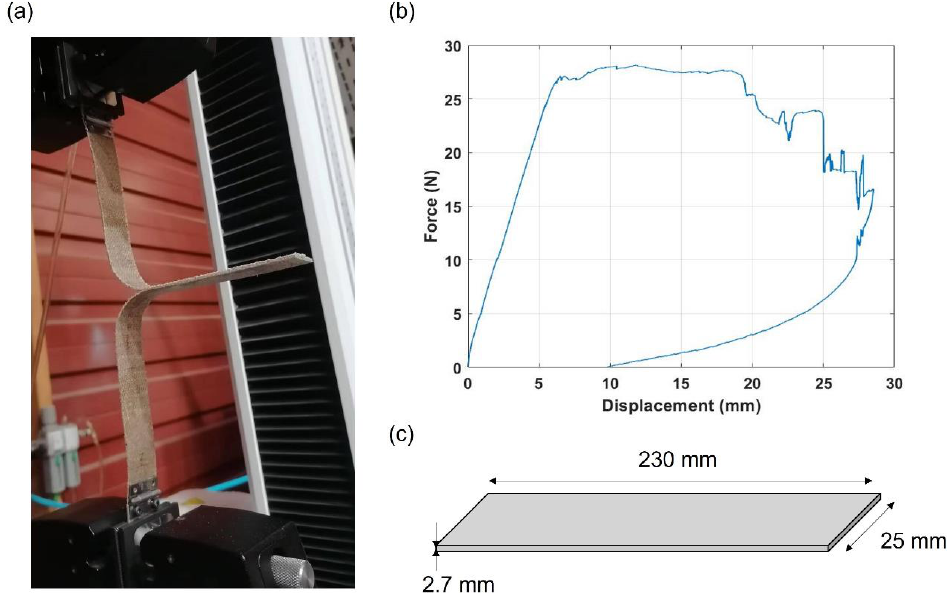
Figure 5. Experimental tests conducted to determine the interlaminar fracture toughness energy in Mode I. ( a ) Experimental setup; ( b ) load–displacement curve; ( c ) geometry of the specimens. Dimension not to